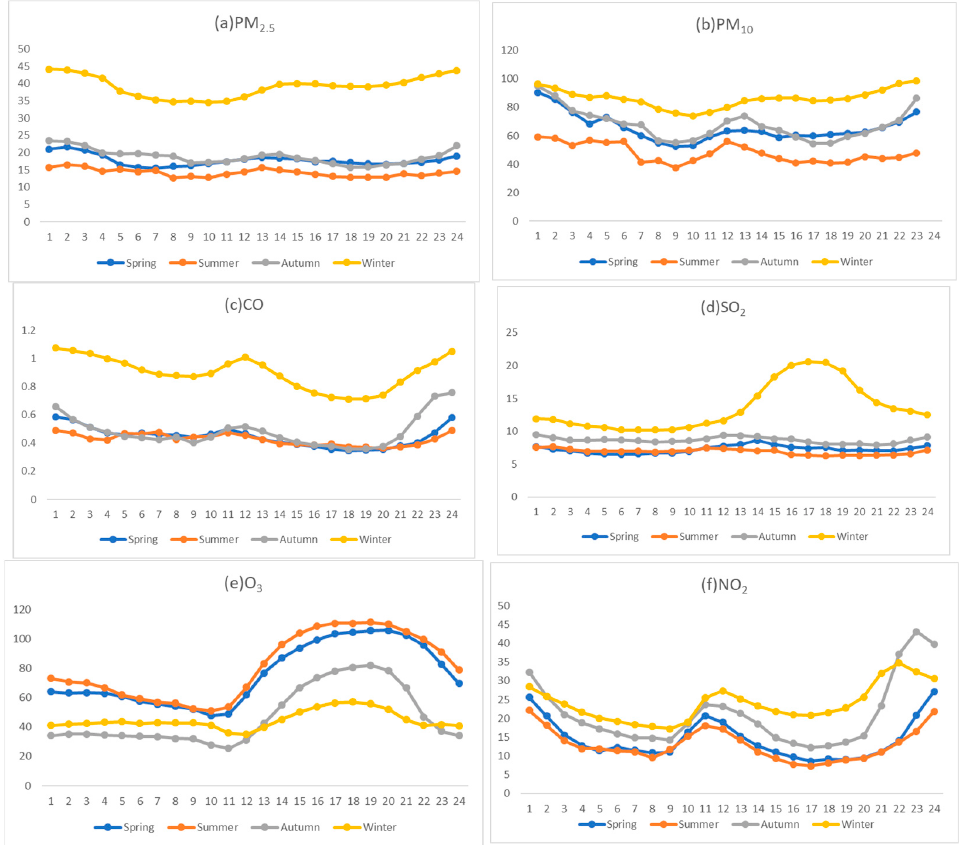
Figure 4. Seasonal variations in the concentrations of six pollutants in Bozhou (CO units: mg/m 3 , others are μ g/m 3 ).